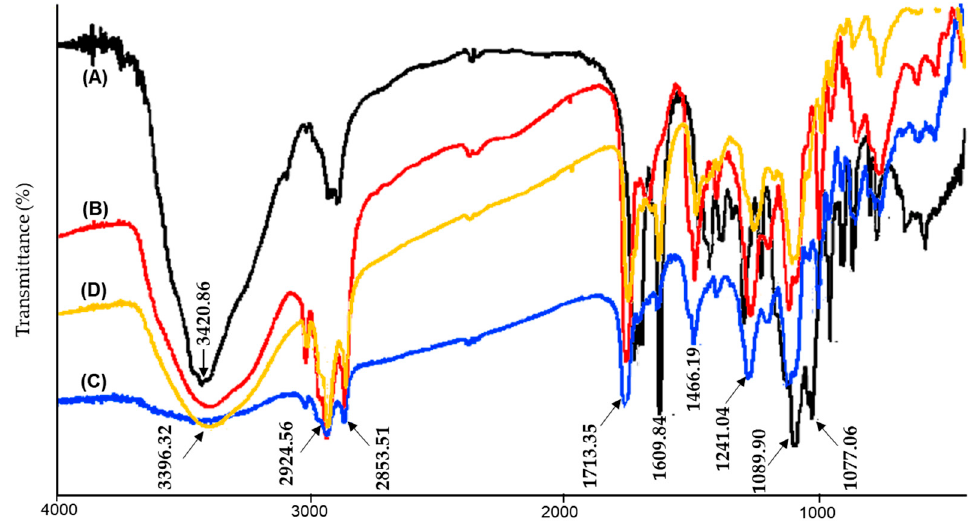
Figure 3. Fourier Transform Infrared spectra (FT-IR) of GTP-PC. GTP ( A ), phospholipids ( B ), physical mixture ( C ), GTP-PC ( D ).